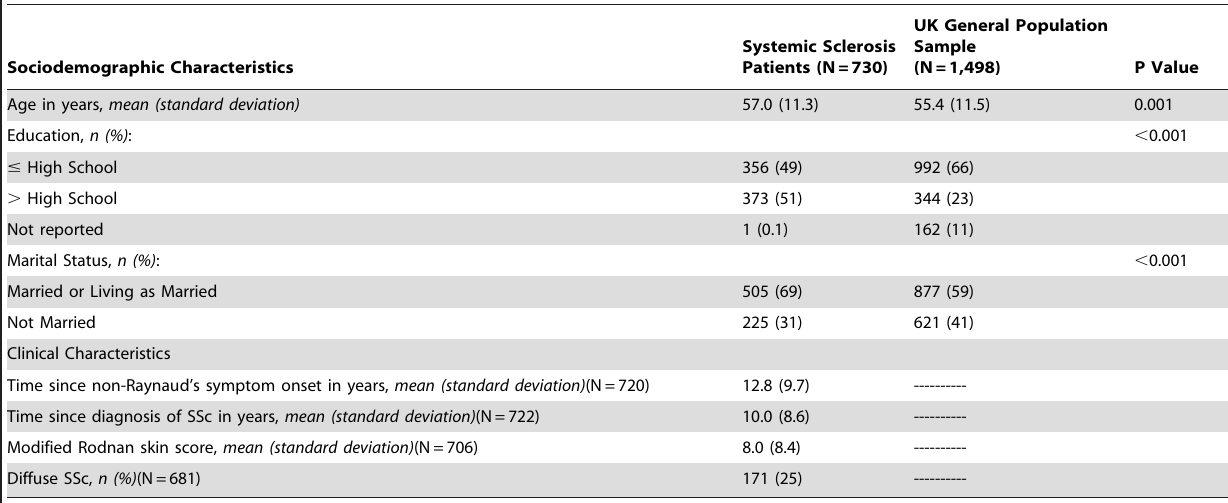
Table 1. Comparison of sociodemographic and clinical characteristics of women with systemic sclerosis and women from a UK general population